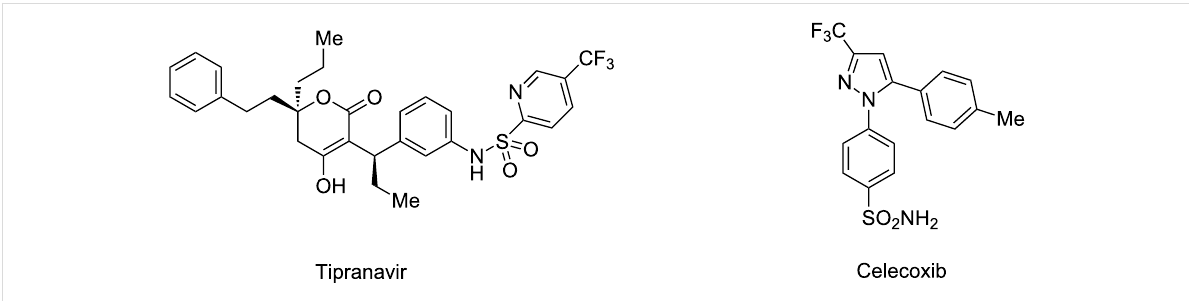
Figure 1: Important drug molecules containing a trifluoromethylpyridine, respectively a trifluoromethylpyrazole